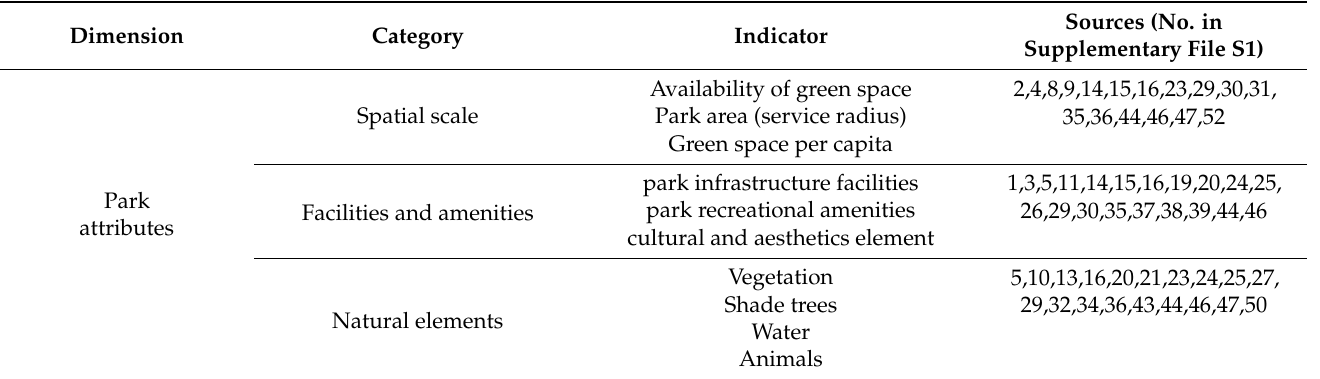
Table 5. Indicators of park